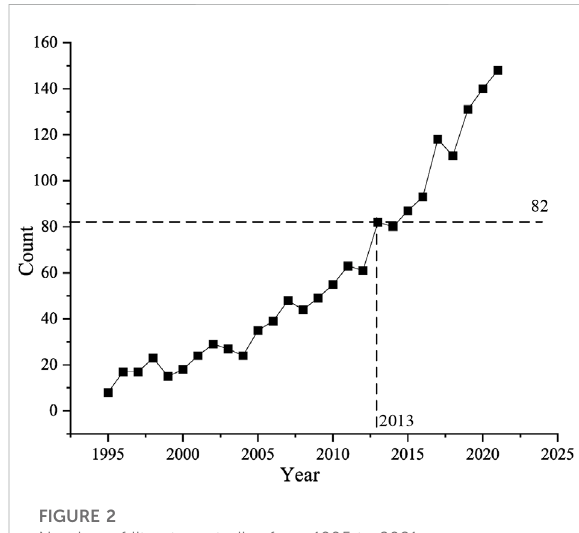
FIGURE 2 Number of literature studies from 1995 to